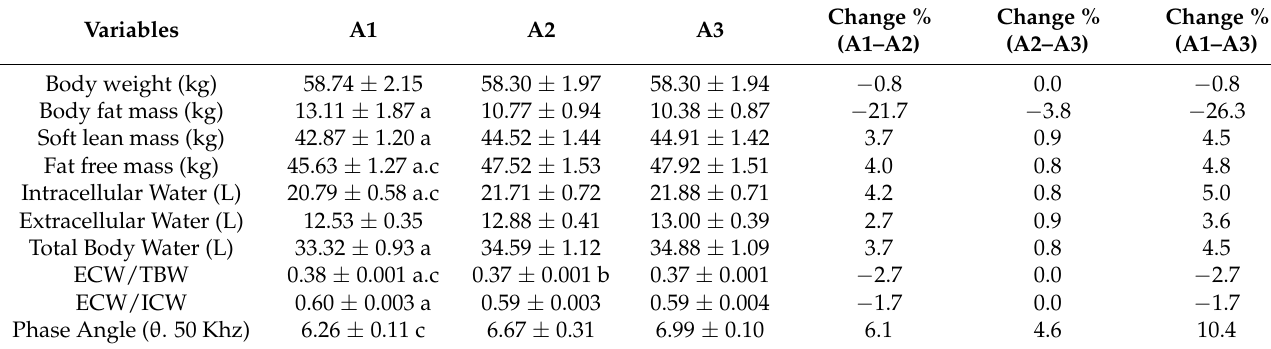
Table 3. Comparisons between assessments by squad average ( n =